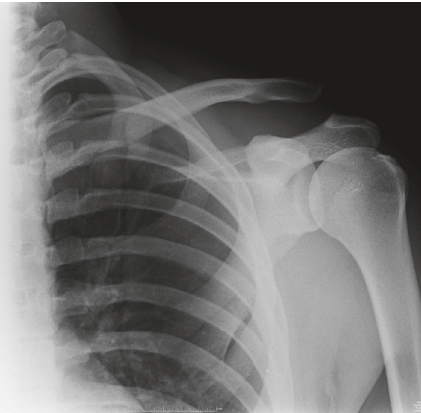
Figure 1: Anteroposterior left ACJ radiograph demonstrating Rock- wood V ACJ dislocation.